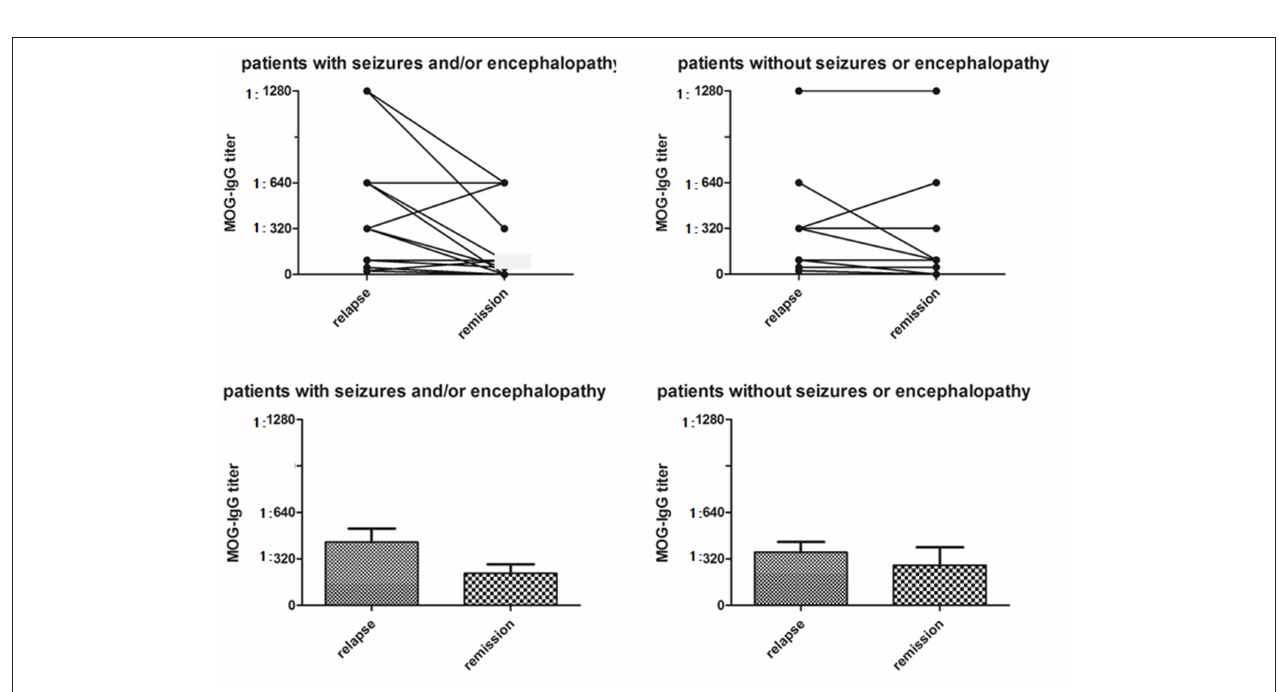
FIGURE 2 | Serum MOG-IgG titers in MOG-IgG positive patients with or without seizures and/or encephalopathy. In the seizure and/or encephalopathy group, MOG-IgG titers were significantly higher at the nadir stage of relapse when compared with titers at last follow-up ( P = 0.021), although there was no difference in serum MOG-IgG titers between relapses and remission in the without seizures or encephalopathy group ( P =